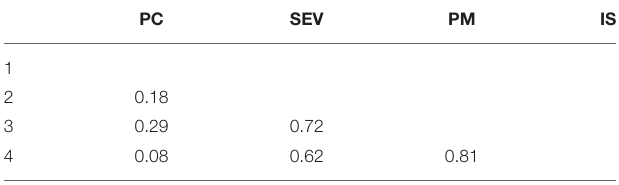
TABLE 2 | Discriminant validity: heterotrait–monotrait (HTMT).